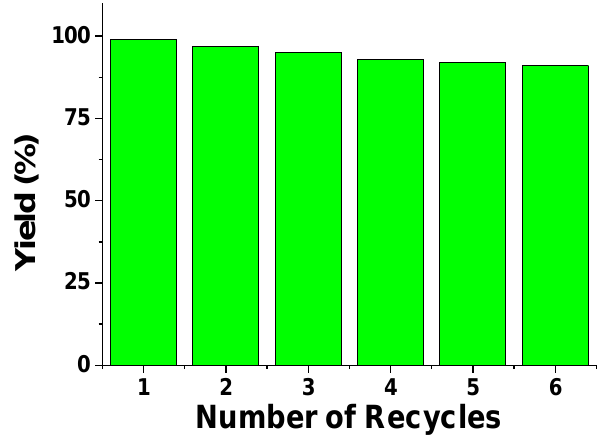
Figure 14. Recycle test of 3D COF (3D-HNU5) for CO 2 capture.